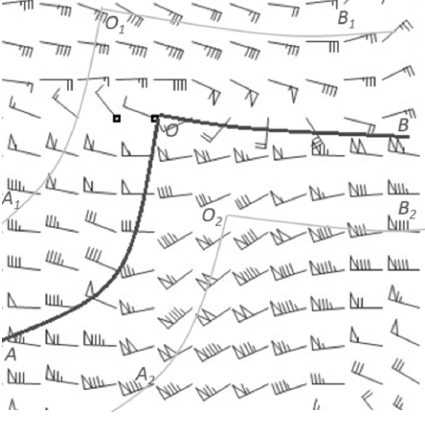
Figure 3. The areas occupied by the longwave trough line.